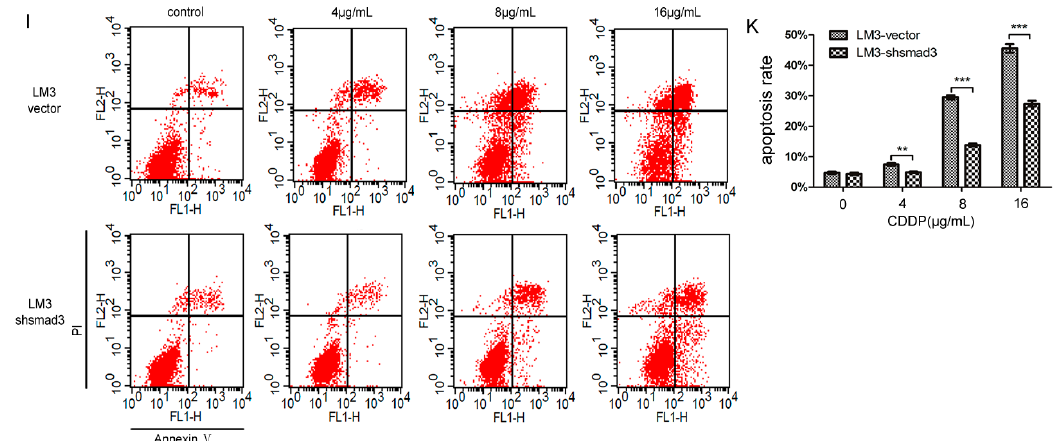
Figure 2. Smad3 increases the sensitivity of HCC to cisplatin in vitro . SMMC-7721 ( A ) and HCC-LM3 ( B ) cells were treated with indicated concentrations of cisplatin for 48 h. The number of viable cells was determined by CCK-8. Relative percentages of live cells were analyzed by comparing with cells without cisplatin treatment; ( C ) The 50% inhibitionary concentration values (IC 50 ) of 7721 and LM3 cells were calculated and analyzed by Graphpad Prism 5.0; ( D – G ) Plate colony formation assay was performed to detect cisplatin sensitivity, and the number of colonies was evaluated 14 days after cell plating. The data are presented as the mean ± S.D. from three wells; ( H – K ) Cell apoptosis assays were examined using Fluorescence activated cell sorting (FACS) 48 h after cisplatin treatment. The percentages of apoptotic cells are presented as the mean ± S.D. from three wells ( ** p < 0.01, *** p < 0.001).